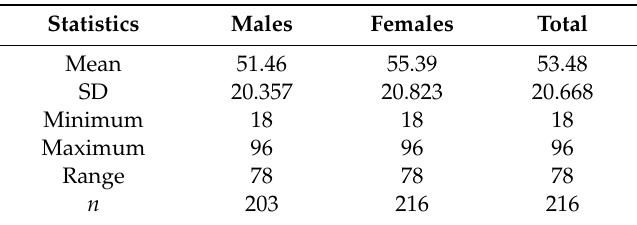
Table 2. Descriptive statistics for chronological age (in years) by